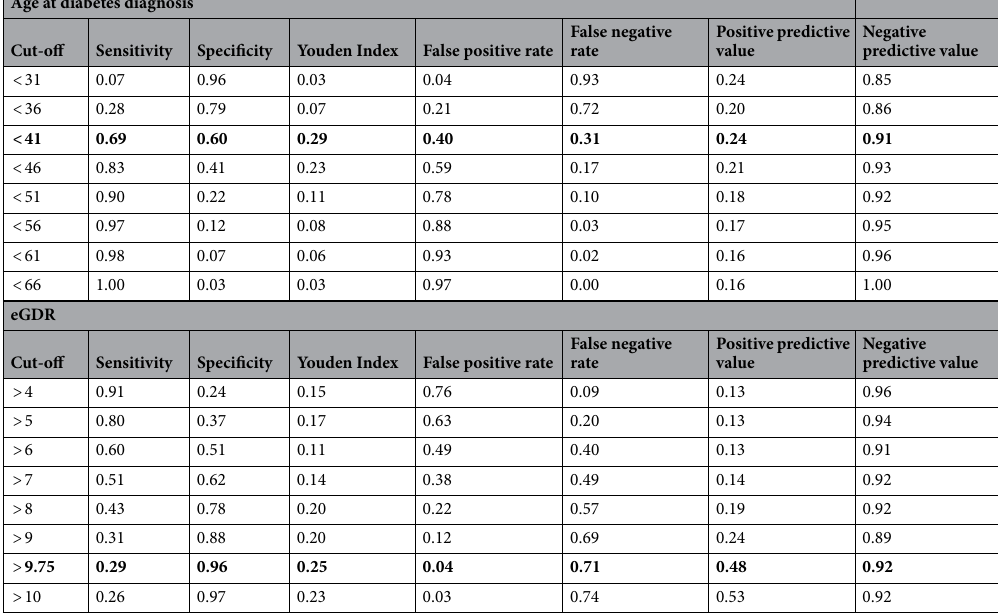
Table 4. Sensitivity and specificity of age at diabetes diagnosis and eGDR cut-off points. Significant values are in [bold]. eGDR, Estimated glucose disposal rate. Age at diagnosis lower than 41 years and an eGDR higher than 9.75 correlates better with LADA and have the best positive and negative predictive